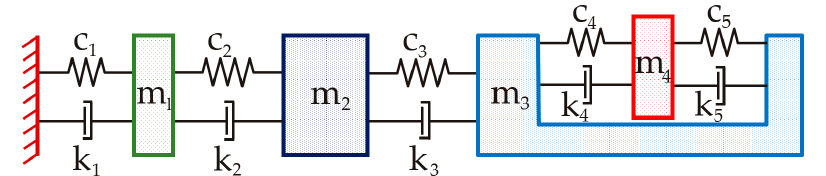
Figure 12. Four-mass dynamic model.